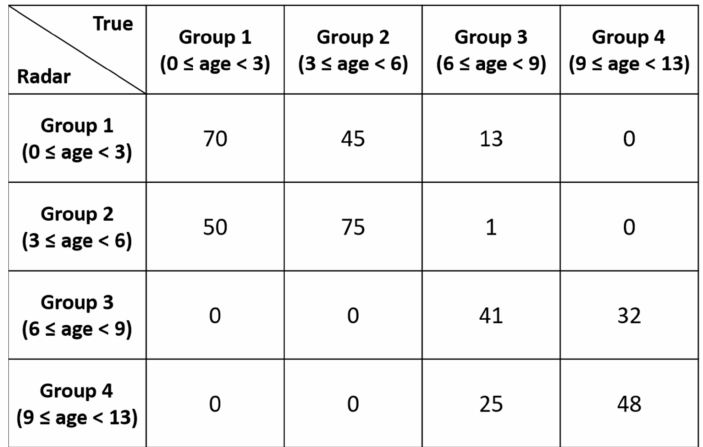
Figure 8. Confusion matrix of the 4 age-group classification.